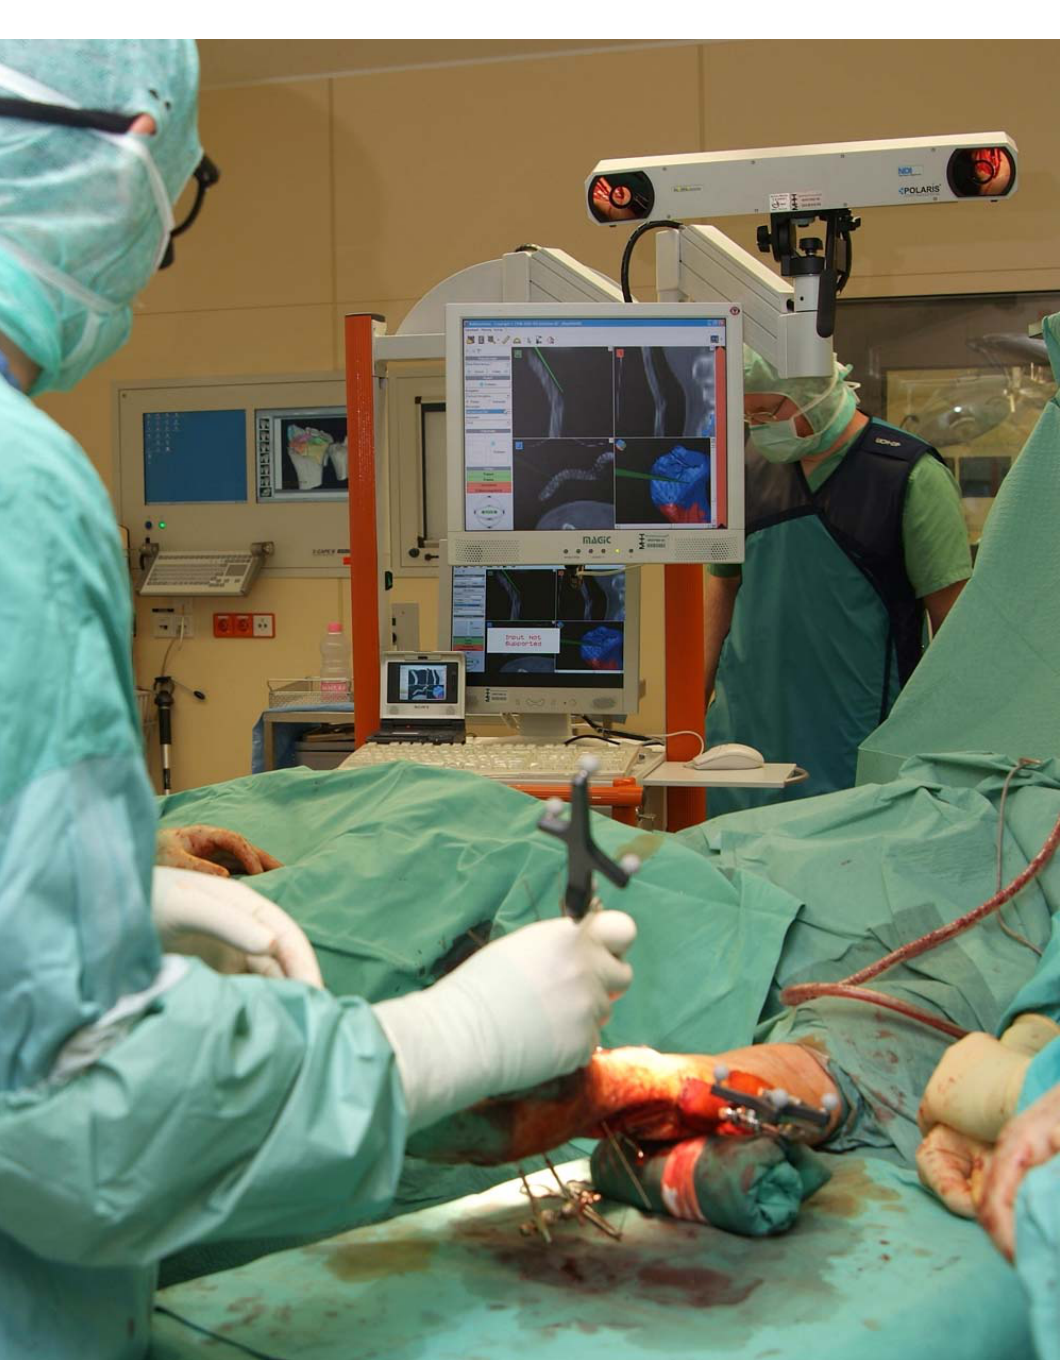
Fig. 5 Navigation-based reduction of a complex intraarticular radius fracture. Preopera- tive CT scans can be used to control the fracture patterns intraoperatively. The navigated pointer is used to track different fracture